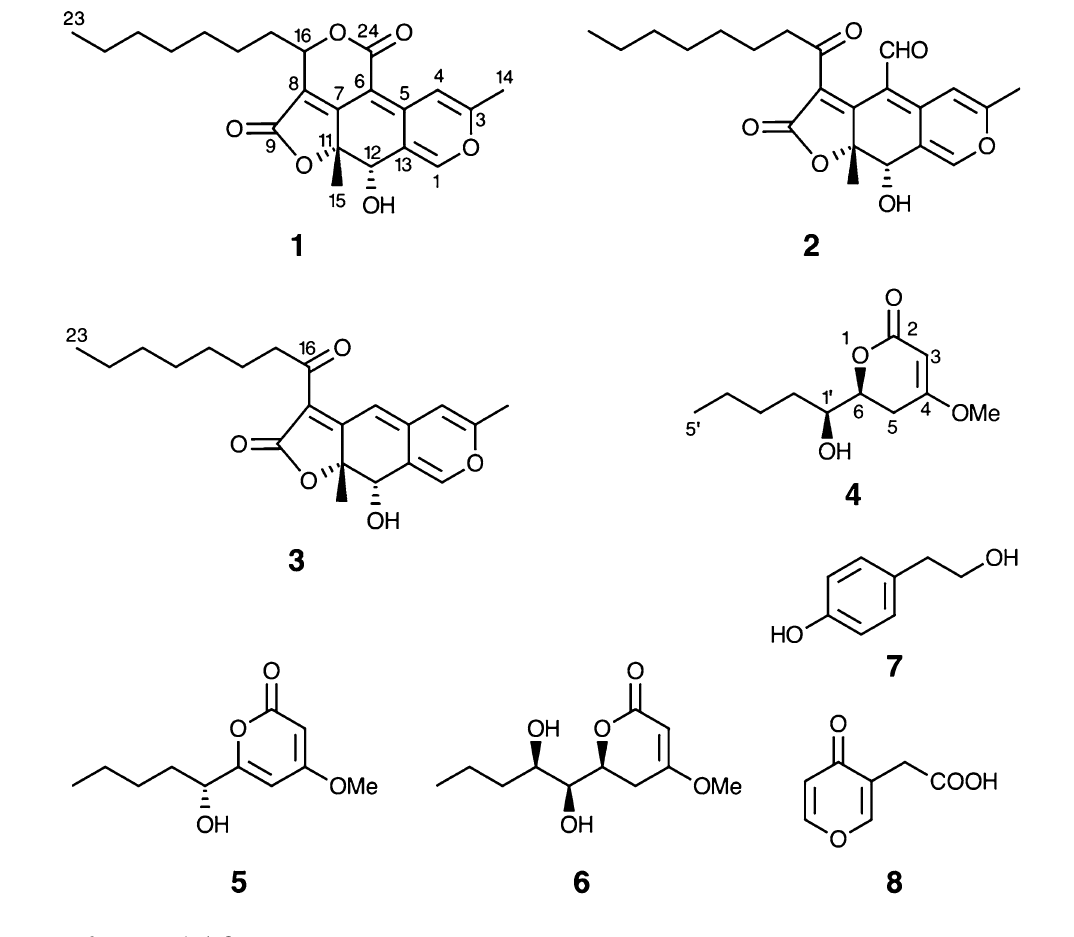
Fig. 1 Structures of compounds 1 –